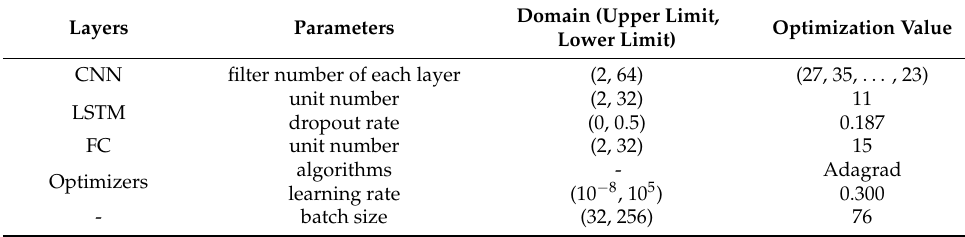
Table 1. The hyperparameters of the presented model (take the vertical direction as an example).